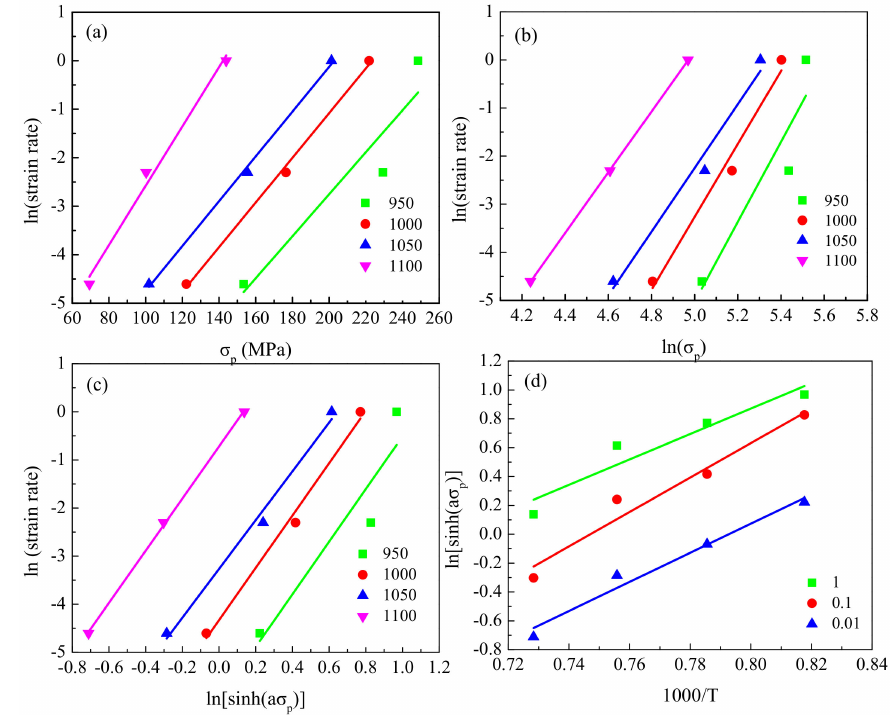
. ε . ε . ε and σ p ; ( b ) ln and ln σ p ; ( c ) ln and lnsinh ( ασ p ); ( d ) lnsinh